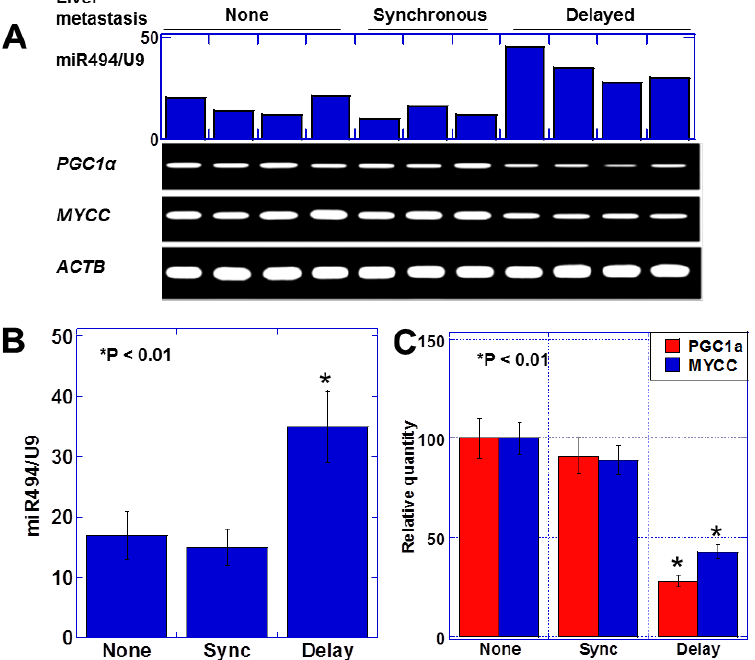
Figure 5. Expression of miR-494, PGC-1α , and MYCC in 11 human CRCs. ( A ) Expression of miR-494, PGC-1α , and MYCC in 11 human CRCs categorized as pT3/pN1. ( B ) Mean expression of miR-494. ( C ) PGC-1α and MYCC expression examined by quantitative RT-PCR. Error bar, standard deviation from three independent trials. None, no liver metastasis; synchronous (Sync), synchronous liver metastasis at primary operation; delayed (delay), liver metastasis delayed more than 2 years after primary operation. * p < 0.01